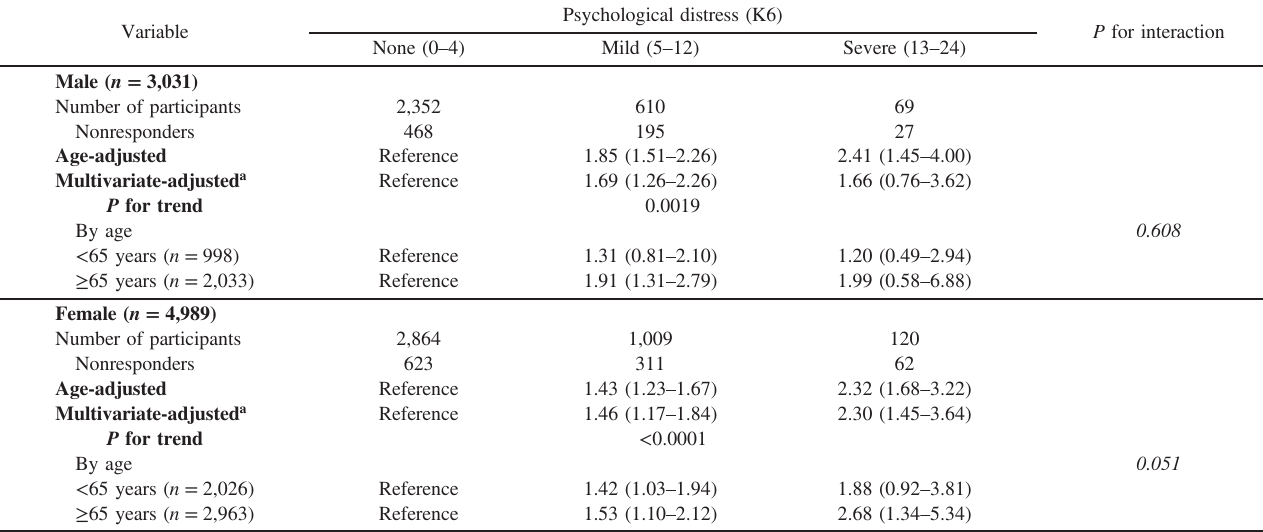
Table 3. Summary of the associations of psychological distress with participation status among survivors